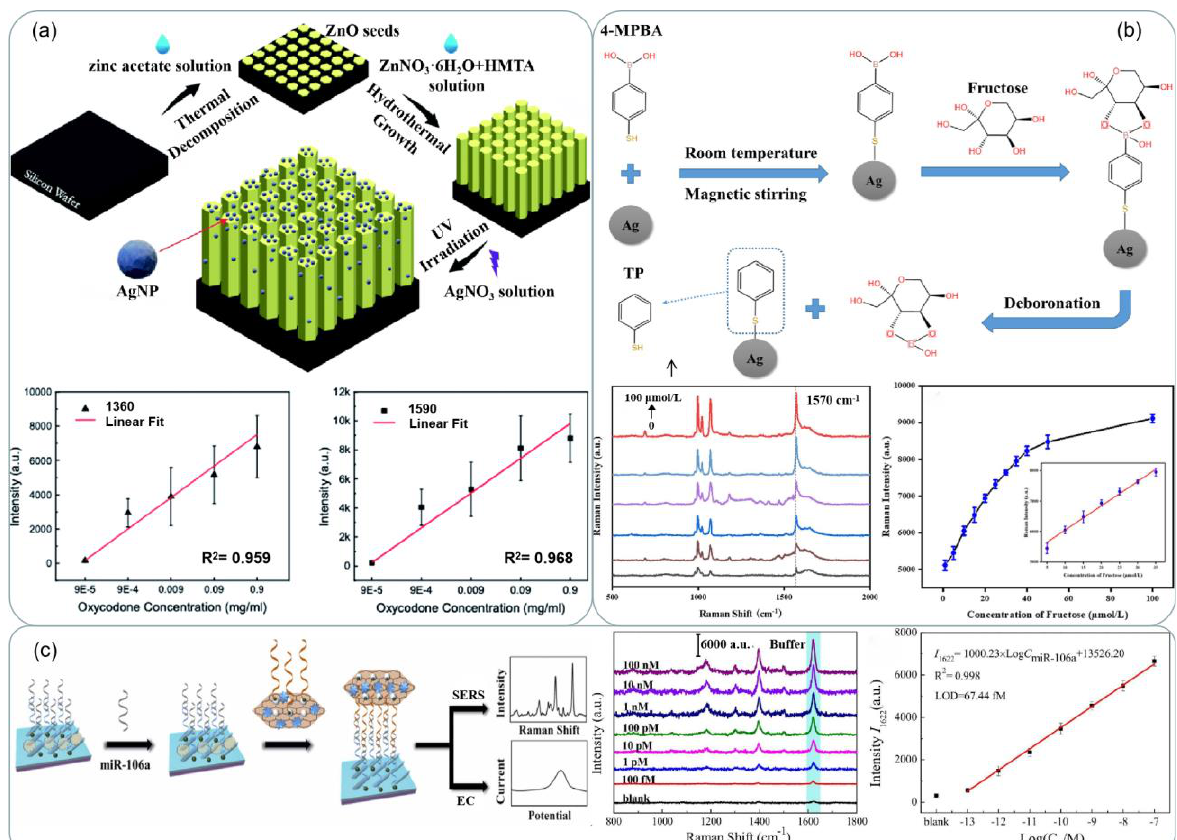
Figure 15. ( a ) Schematic of the Ag@ZnO chip and its fabrication process. The signal intensity versus oxycodone concentrations at the characteristic peaks at 1360 cm − 1 and 1590 cm − 1 . Reprinted with permission from Ref. [139]. Copyright 2021, RSC Adv. ( b ) Schematic of the synthesis of AgNPs- 4MPBA and the process of fructose-induced deboronation reaction. SERS spectra of AgNPs-4MPBA substrate and fructose in urine with concentrations: 0, 0.5, 1, 5, 50, 100 μmol/L, Working curve of fructose concentration and SERS peak intensity at 1570 cm − 1 in urine. Reprinted with permission from ( c ) Schematic illustrations of the sandwich-structured sensing system for SERS/electrochemical (EC) dual-mode detection of miR-106a. Reprinted with permission from Ref. [154]. Copyright 2022, Sensors and Actuators B: